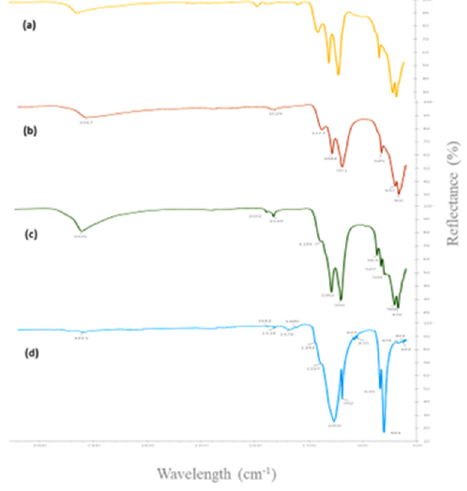
Figure 6. FTIR spectra of: ( a ) potassium jarosite, ( b ) JKCa, ( c ) JKCa2 and ( d ) JKAll. According to the above, for the case of JKCa and JKCa2, both exhibit absorption bands having comparable shapes and positions, and only a few peaks of calcium sulfate appear near 590, 660 and 1600 cm − 1 [33]. On the other hand, JKAll shows a typical spectrum of the strontium sulfate [34]. Figure 7a shows just one band, which is primarily due to the structural OH stretching mode and includes water modes, especially for the synthetic samples. Reflectance spectra in this region are nearly saturated for these sulfates [35].